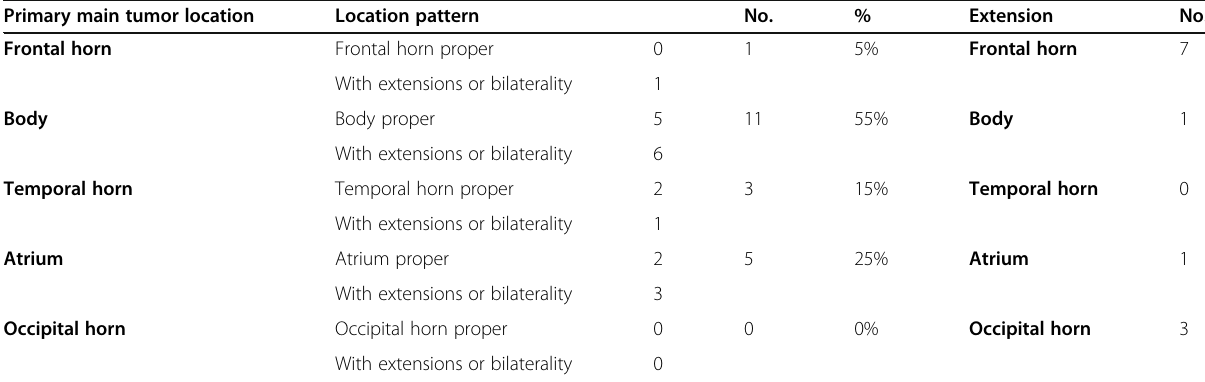
Table 2 Large or bilateral IVTs: primary main locations and extensions Primary main tumor